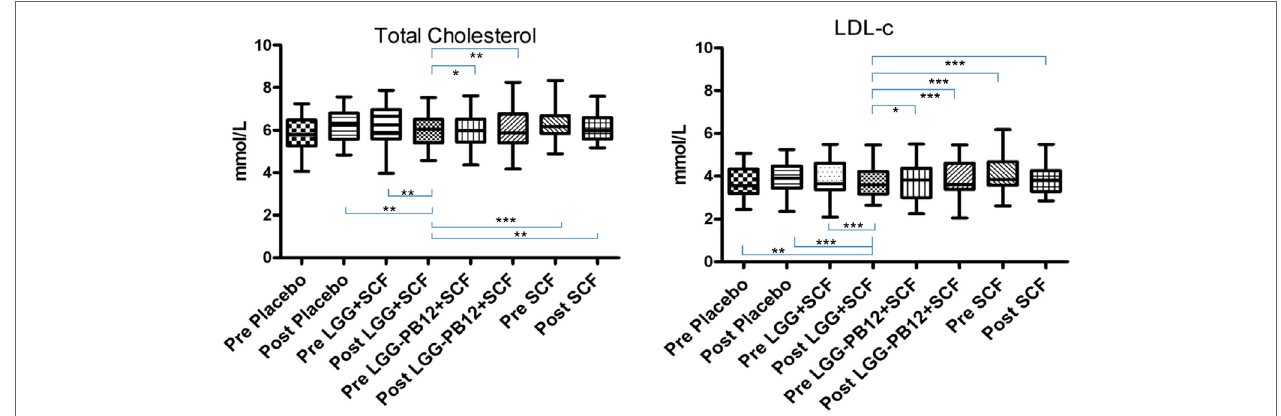
FiGUrE 3 | Total cholesterol (a) and LDL-cholesterol concentrations (B) in each group after the treatment, in volunteers with raised cholesterol (total cholesterol